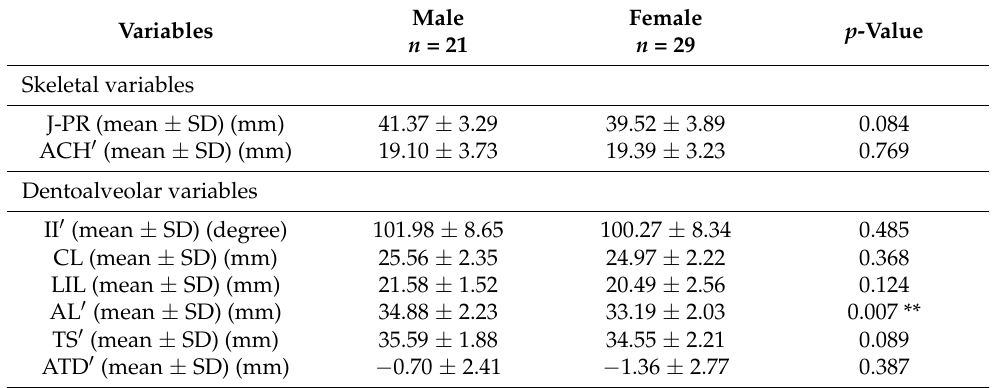
Male Female p -Value n = 21 n = 29